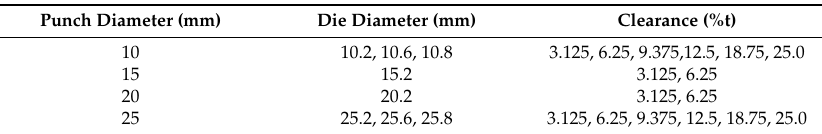
Table 1. The values of punch diameter, die diameter, and clearance/plate-thickness ratio used in the punching experiments.